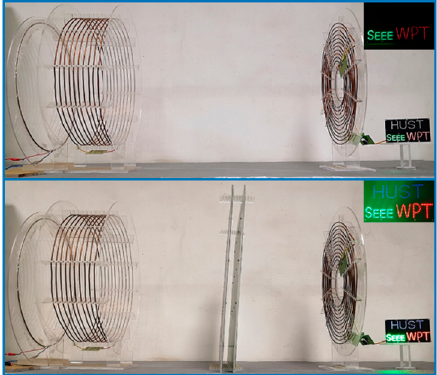
Figure 12. WPT experiment with an LED lamp panel.